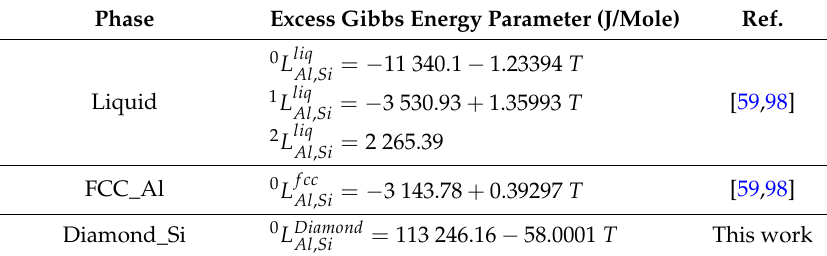
This work This work